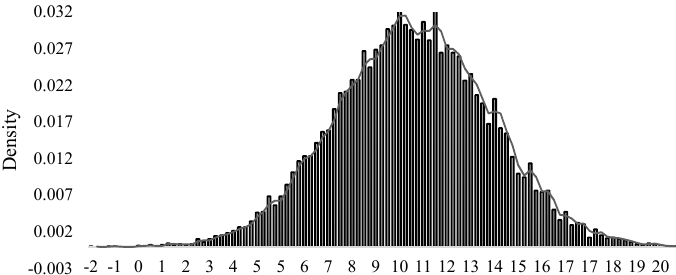
Figure 7. The probability density distribution of a certificate price (source: authors calculation, using Crystal Ball software (Oracle, Redwood Shores, United States).